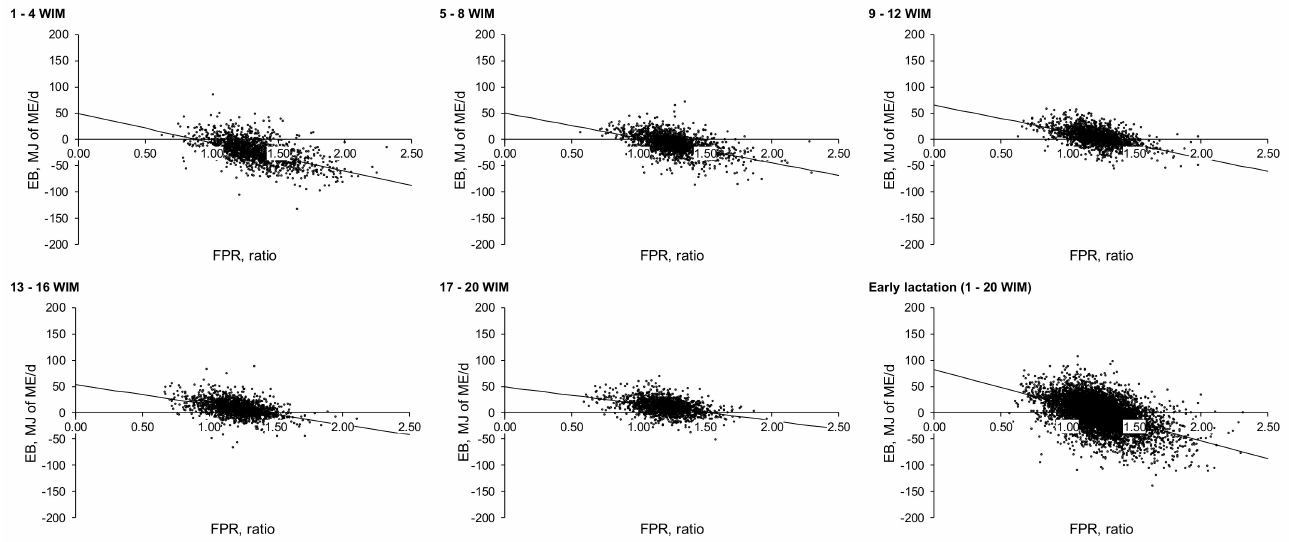
Figure A1. Linear relationships between fat-to-protein ratio in milk (FPR) and daily energy balance (EB, MJ of ME/day)